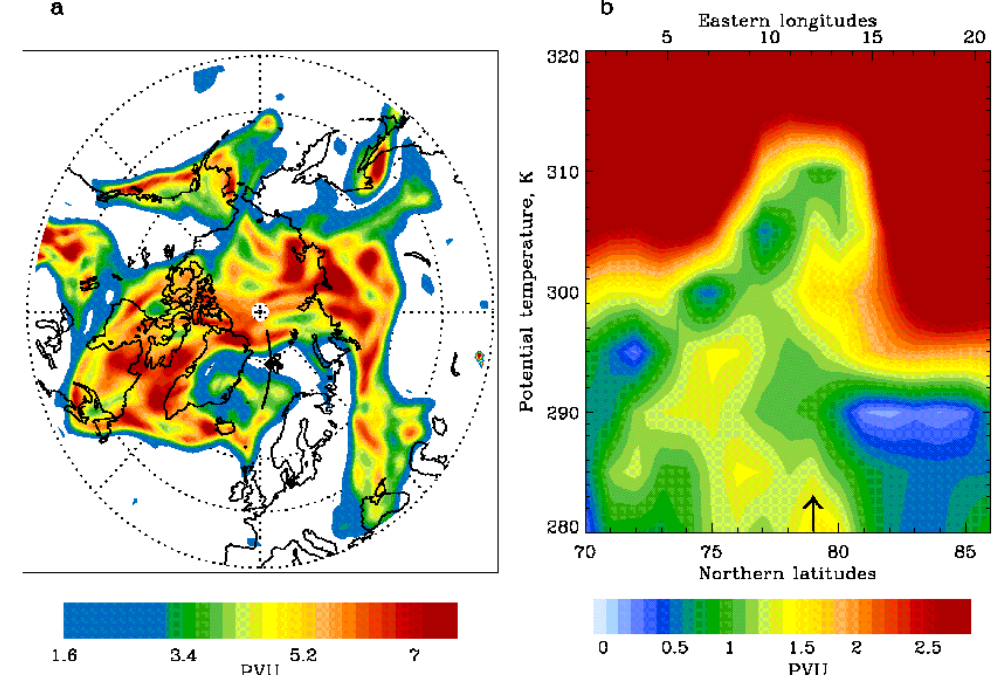
Fig. 9. (a) PV chart for 310K at 12:00UTC on 27 November 1994. Ny- ˚Alesund is marked with a diamond. Only PV > 1.6PVU is coloured (b) Cross section of PV along the black line from (a) across the tropospheric filament. The station is marked with an